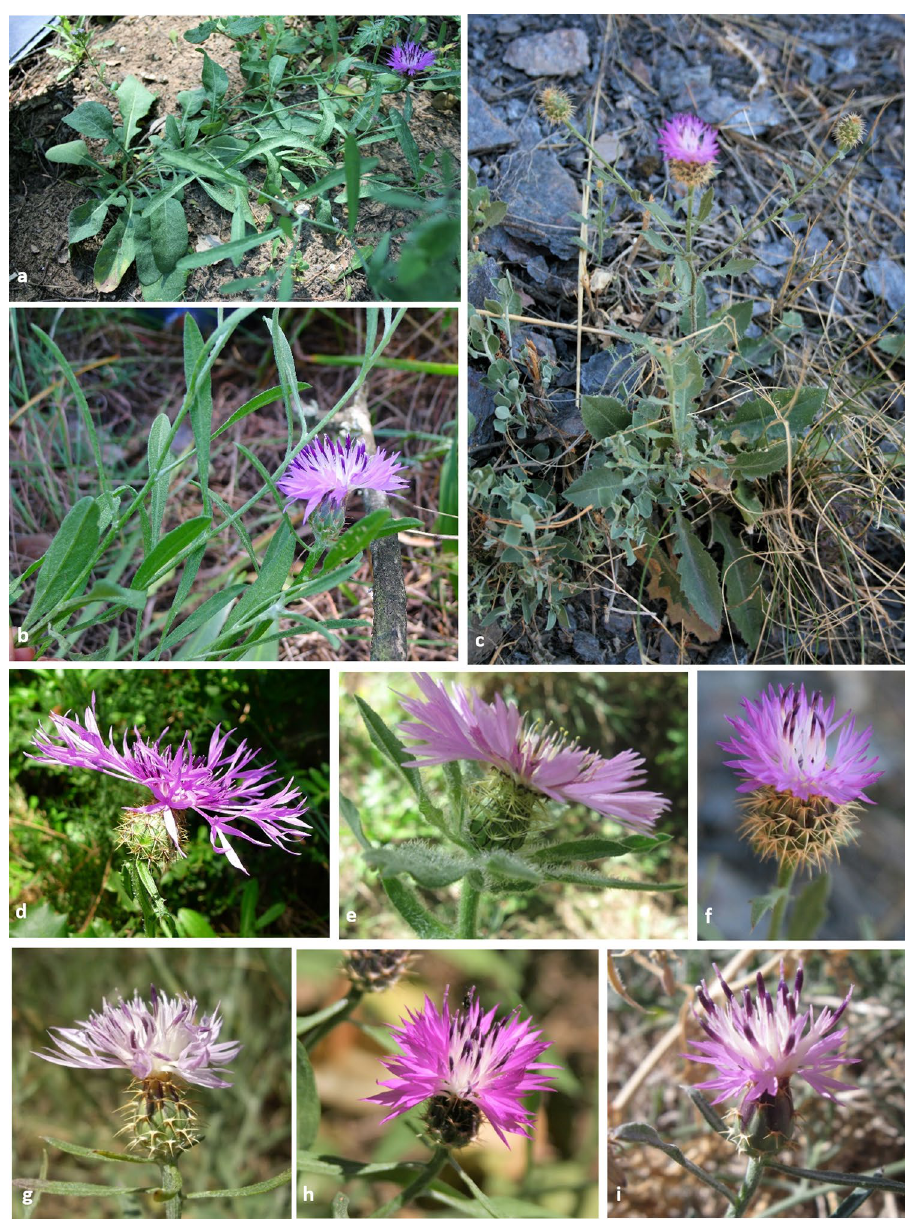
Figure 1. Plants of the observed Centaurea taxa in Andalusia and detail of their capitula. Plants: ( a ) Plant showing intermediate traits between C. aspera ssp. aspera and ssp. scorpiurifolia (Cádiz). ( b ) C. aspera ssp. aspera (Granada). ( c ) C. aspera ssp . scorpiurifolia (Almería). Capitula: ( d ) C. sphaerocephala (Cádiz). ( e ) C. pullata (Cádiz). ( f ) C. aspera ssp . scorpiurifolia (Almería). ( g ) C. aspera ssp. aspera (Granada). ( h ) Plant showing intermediate traits between C. aspera ssp. aspera and ssp. scorpiurifolia (Cádiz). ( i ) C. aspera ssp. stenophylla